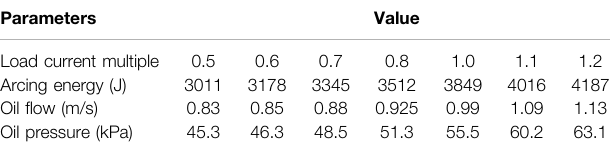
TABLE 3 | Oil fl ow velocity and oil pressure under different